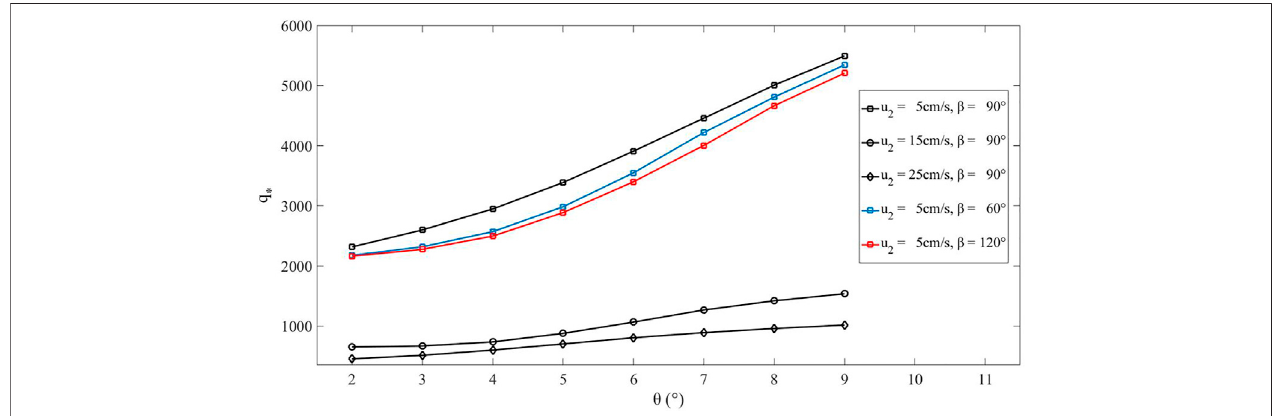
FIGURE 3 | Critical threshold of dimensionless discharge q * derived from numerical simulations as a function of river slope θ , by considering different dynamic conditions for the river and the landslide. Values of q * are obtained as an average from the time that the landslide starts entering the river until the time that the landslide dam